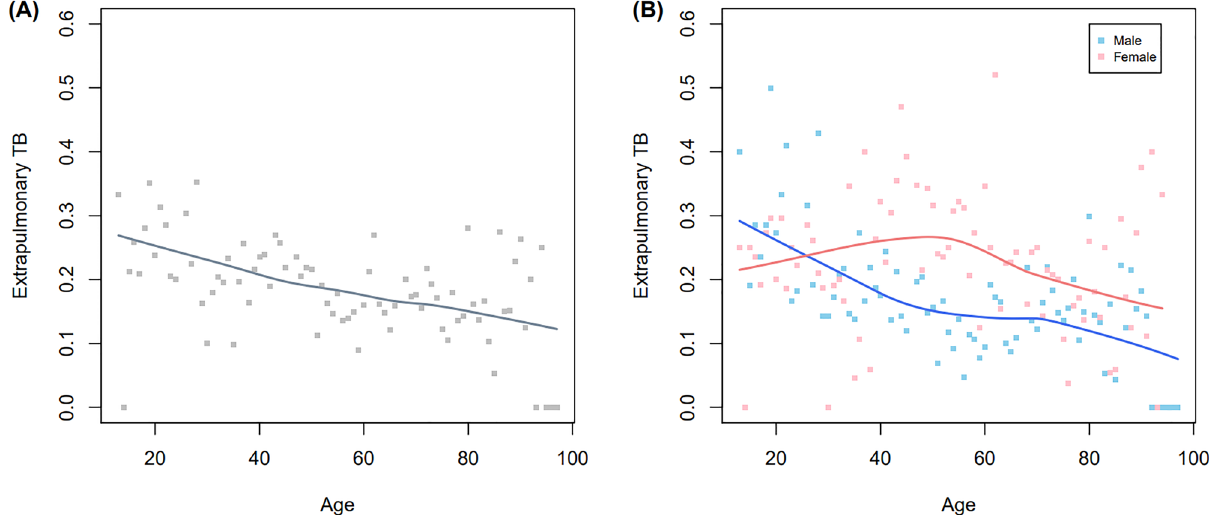
Figure 2. Association of sex and extrapulmonary tuberculosis among all the enrolled tuberculosis patients: changes of proportions of extrapulmonary tuberculosis according to age ( A ), stratified by sex ( B ). TB tuberculosis.